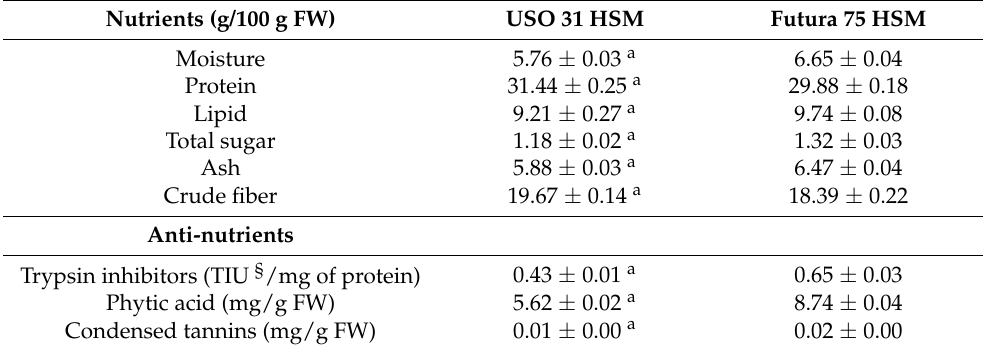
Table 2. Determination of nutrient and anti-nutrient compounds in USO 31 and Futura 75 hempseed meal (HSM). Data are expressed as g/100 g of fresh weight (FW) and represent the mean ± standard deviations (SD) of three independent experiments ( n =